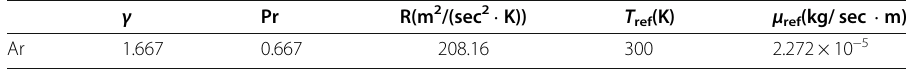
Table 3 Physical properties of Argon